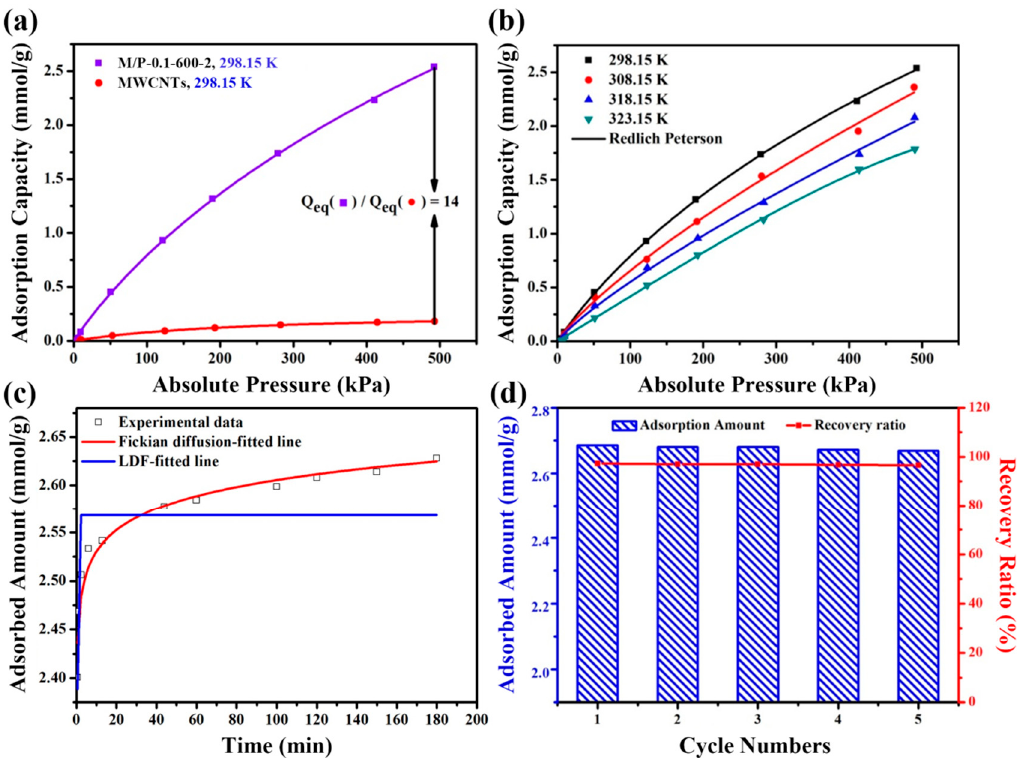
Figure 5. ( a ) The CO 2 adsorption capacity comparison of M/P-0.1-600-2 and MWCNTs absorbents. ( b ) Redlich–Peterson-fitted adsorption isotherms of M/P-0.1-600-2 at various temperatures. ( c ) Adsorption kinetics of CO 2 on M/P-0.1-600-2. ( d ) Regeneration performance of A-TDP-12 on CO 2 adsorption.